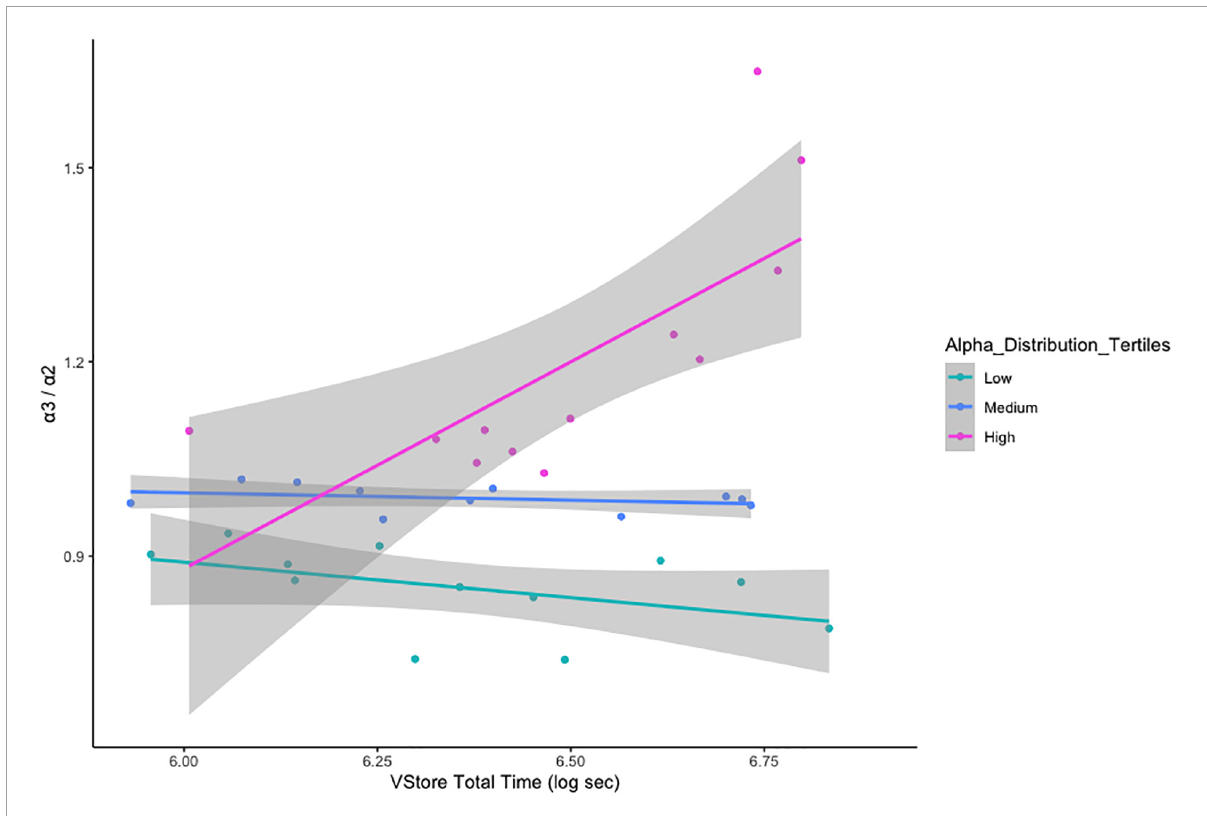
FIGURE4 Correlations between VStore Total Time and α 3/ α 2 ratios stratified by